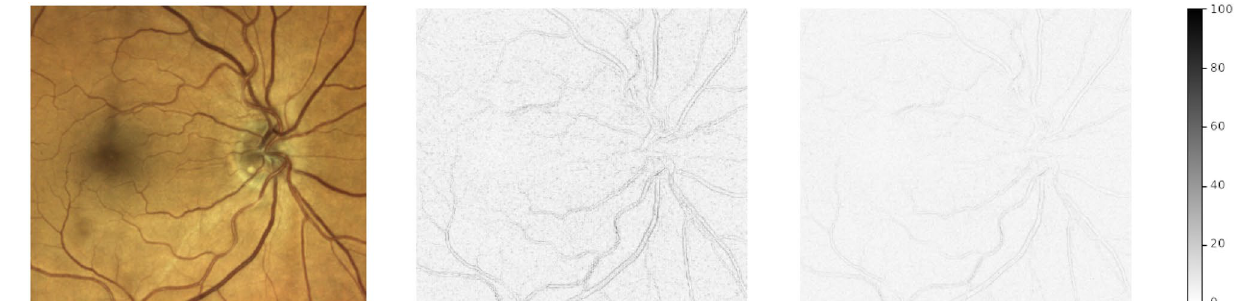
Figure 6. Example of difference maps between the original examination (left) and two down-sampled versions with the resolutions 299 px (middle) and 799 px (right), respectively. Absolute intensity differences (original intensity range: [0, 255]) are color coded in grayscale. In the middle image, differences are mainly seen in the areas of the vessel walls, reflecting a loss of detail in these regions at the lower resolution. Differences are strongly reduced in the picture downsampled to 799 px, hence, anatomical details are better